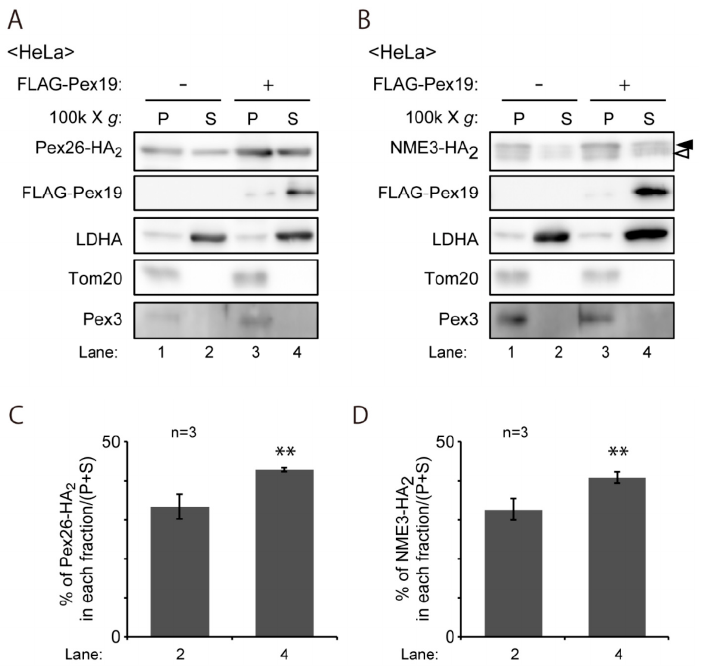
Figure 5. Overexpressed Pex19 stabilizes the coexpressed NME3-HA 2 in the cytosol. ( A ) PEX26-HA 2 was expressed alone or together with FLAG-PEX19 for 20 h. Cells were fractionated into organelle pellet (P) and cytosol (S) fractions. Equal aliquots of each fraction were analyzed by SDS-PAGE and immunoblotting with antibodies to HA, FLAG, lactate dehydrogenase A (LDHA), a cytosolic protein; Tom20, a mitochondrial outer membrane protein; Pex3, a PMP. ( B ) NME3-HA 2 was likewise expressed and assessed for its subcellular distribution as in ( A ). Two bands (solid and open arrowheads) were detected as in Figure 4B. ( C , D ), relative Pex26-HA 2 and NME3-HA 2 signals in cytosol fractions (S) were represented as a percentage of the total signal (S + P) (n = 3). ** p < 0.01, by Student’s t